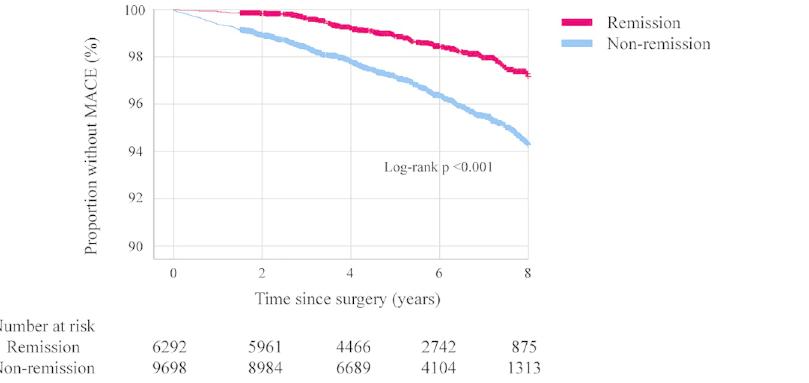
Fig 3. MACE-free survival in patients experiencing remission of hypertension at 2 years and those not experiencing remission (unadjusted Kaplan–Meier curve). MACE, major adverse cardiovascular event.